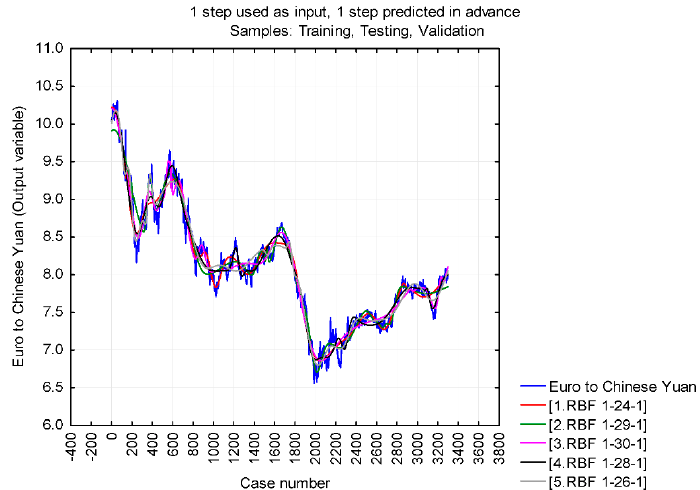
Figure 7. Line graph—development of Euro exchange rate to Yuan predicted by neural networks in comparison with the actual exchange rate in the monitored period. (Source: Own processing.)